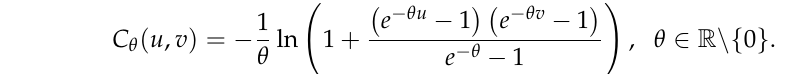
, where ( X 1 , X 2 ) follows Gumbel Copulas. X 1 + X 2